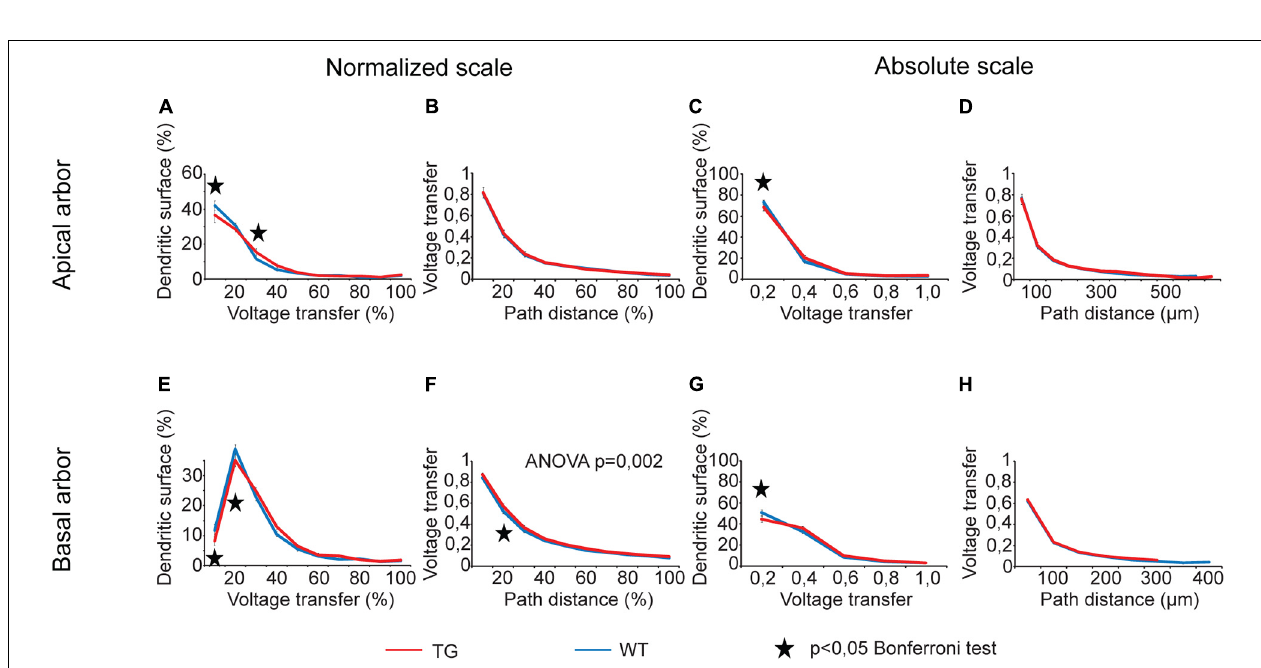
FIGURE 7 | Alterations in sinusoid voltage transfers in advanced tauopathy. Comparison graphs showing alterations in sinusoid voltage transfers of TG (red lines) neurons relative to control, WT neurons (blue lines). Overall statistical evaluations of comparison graphs were made by two-way ANOVA tests. Significance levels of these ANOVA tests were indicated where statistically significant overall alteration in comparison graphs was found (elsewhere p > 0.05). Asterisks mark path distance regions and transfer intervals with statistically significant differences between WT and TG neurons (Bonferroni post hoc test, p < 0.05). Distance regions and transfer intervals with less than 3–3 data points in TG-WT comparisons were omitted from statistical tests.